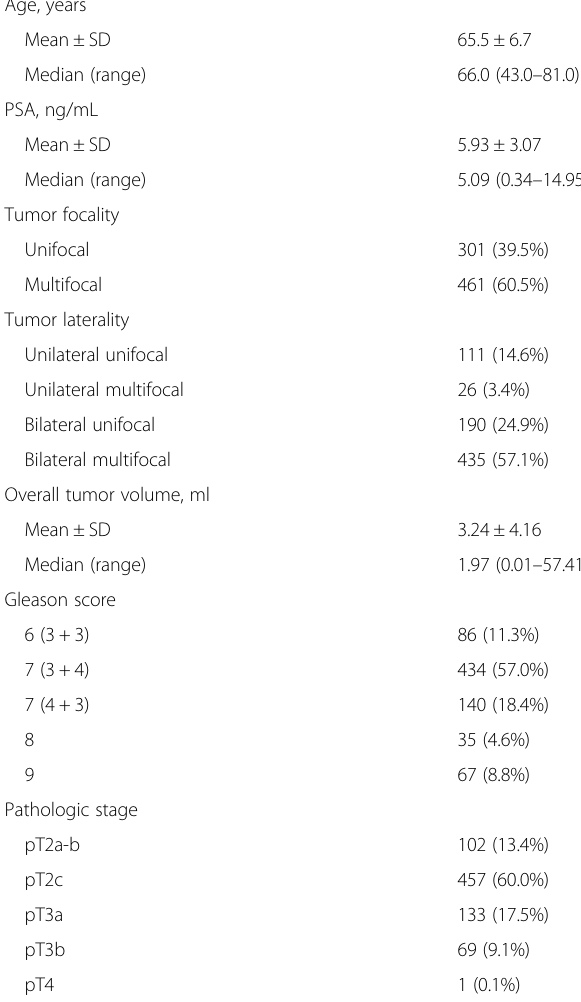
Table 1 Baseline characteristics of 762 radical prostatectomy